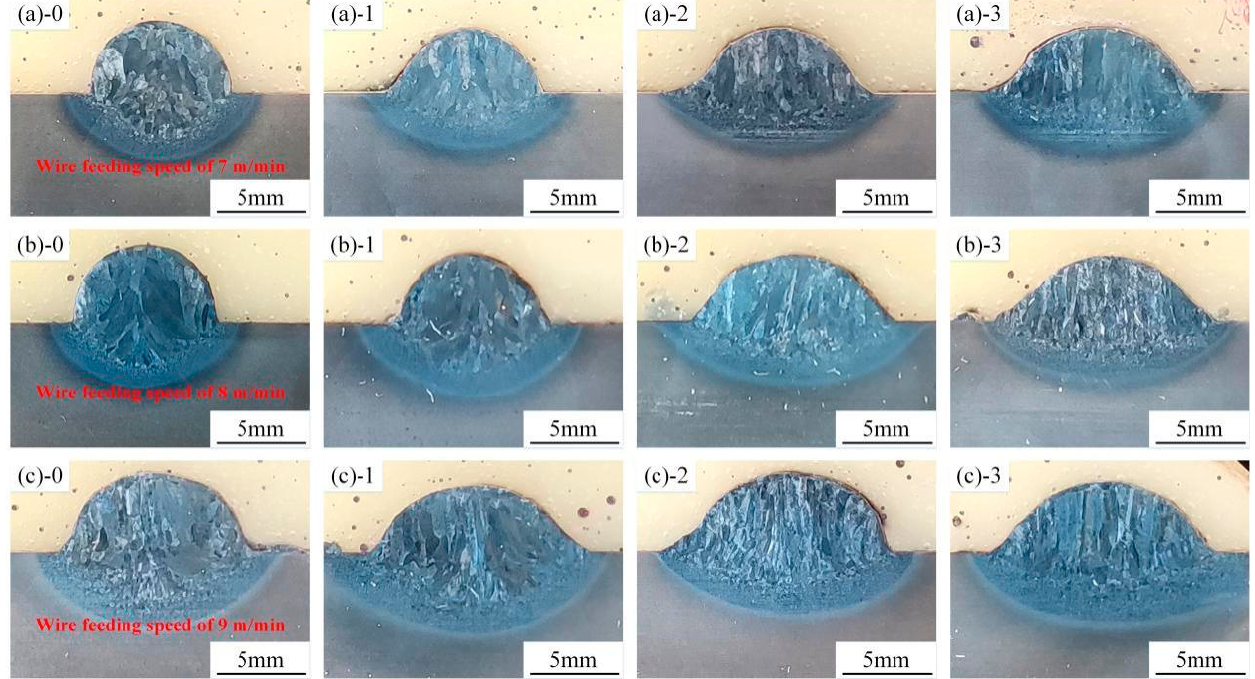
Figure 3. Cross-sectional morphologies of titanium alloy deposition layer: ( a ) Wire feeding speed of 7 m/min with different magnetic excitation currents, ( b ) Wire feeding speed of 8 m/min with different magnetic excitation currents, ( c ) Wire feeding speed of 9 m/min with different magnetic excitation currents.